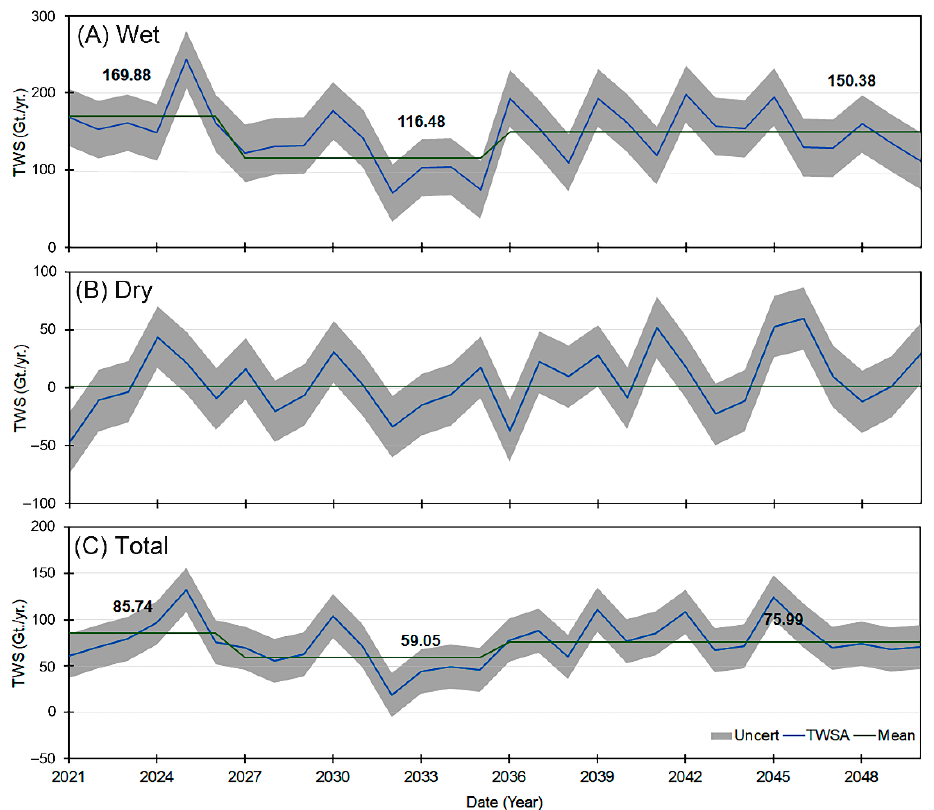
Figure 10 . The projected changes in mean TWS between 2021 to 2050 in the NRB during wet ( A ) and dry ( B ) seasons, and plot ( C ) shows the total water storage during the two seasons.